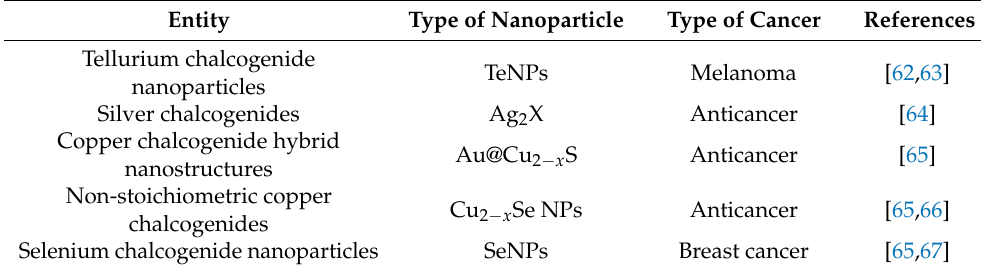
Table 6. Types of chalcogenide nanoparticles with their applications in